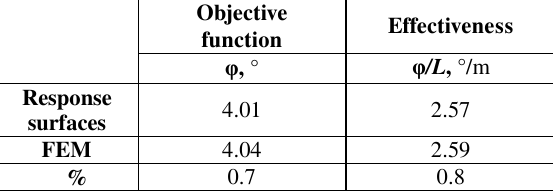
Table 3. Objective function and effectiveness